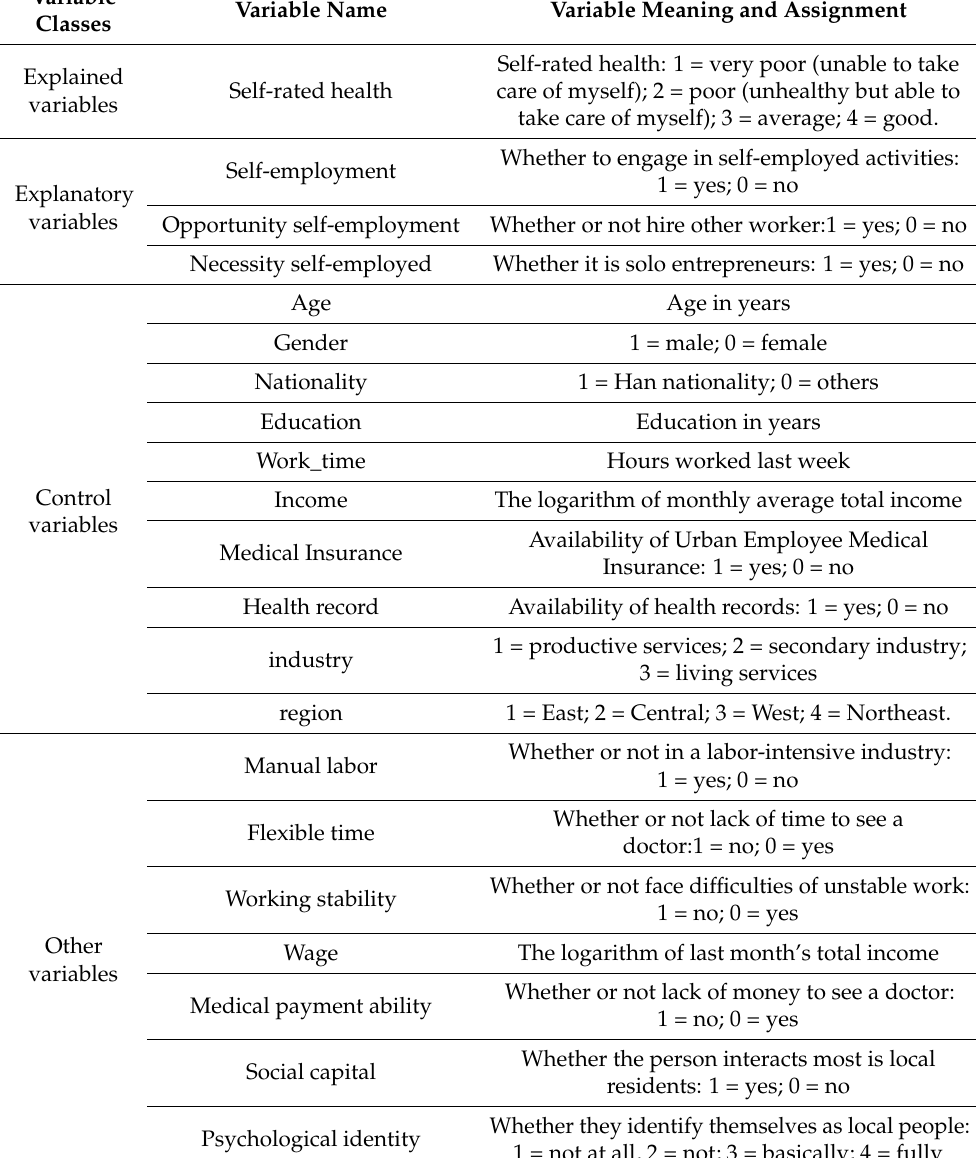
Table 1. Variable selection, definition, and